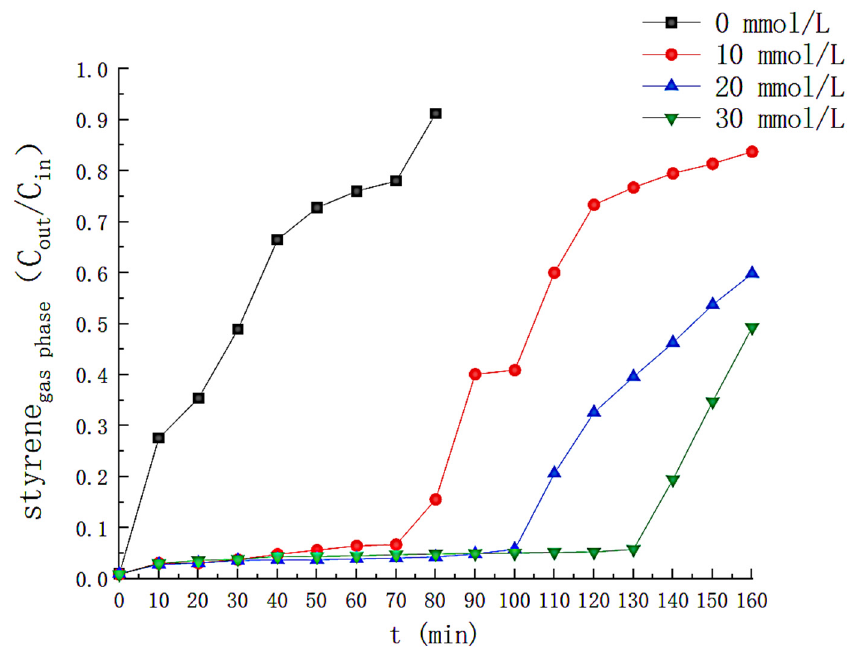
Figure 10. Effect of hydrogen peroxide concentration on removal efficiency of